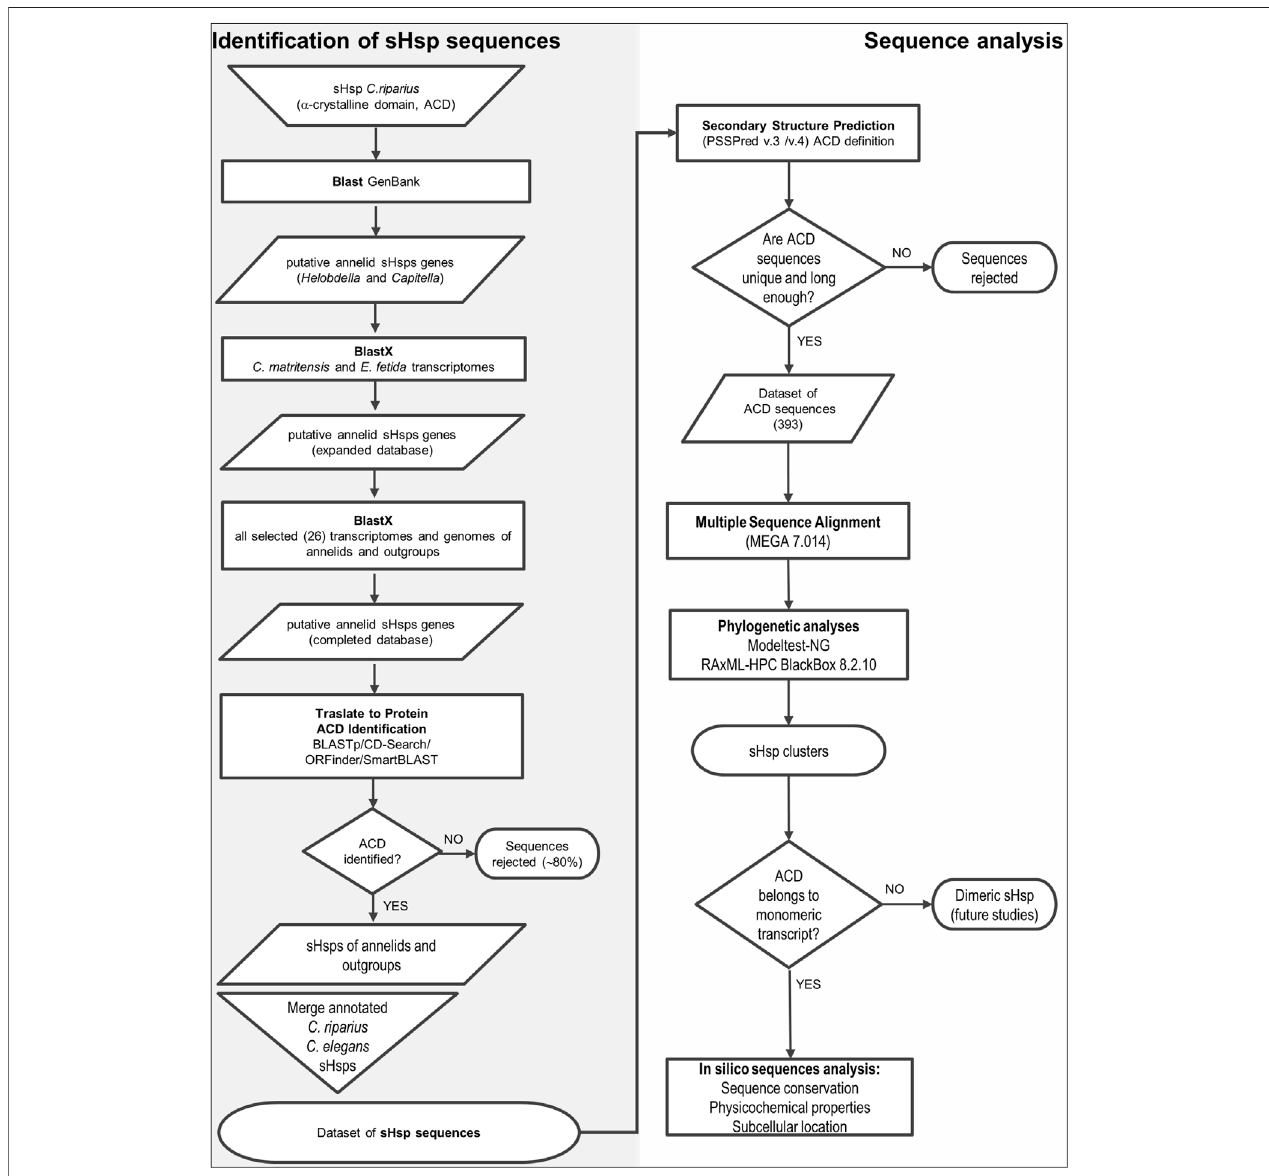
FIGURE 2 | Flow chart of identi fi cation and analysis of sHsp.